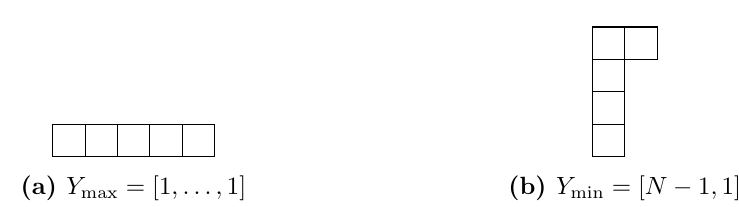
Figure 1. A maximal puncture (left) corresponds to a Young diagram with N columns of height 1. A minimal puncture (right) corresponds to a Young diagram with one column of height N (cid:0) 1 and one column of height